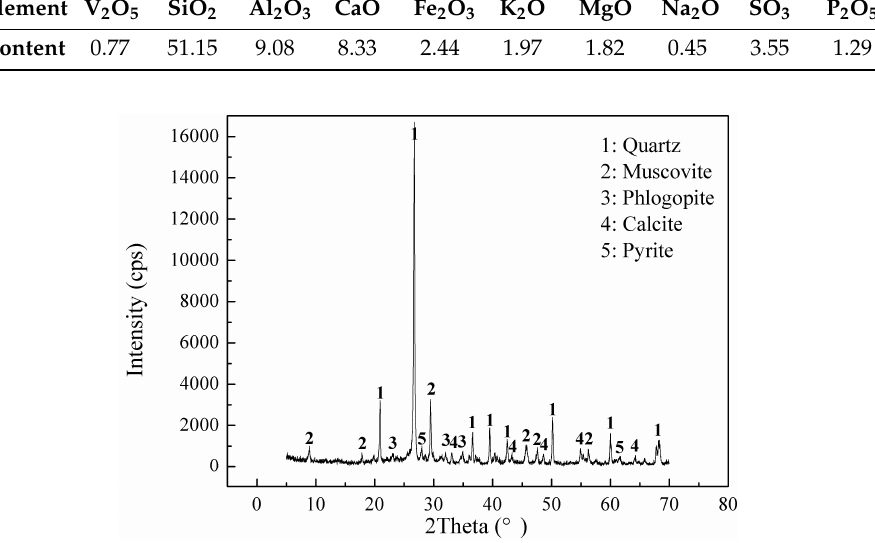
Figure 1. XRD image of stone coal [16].